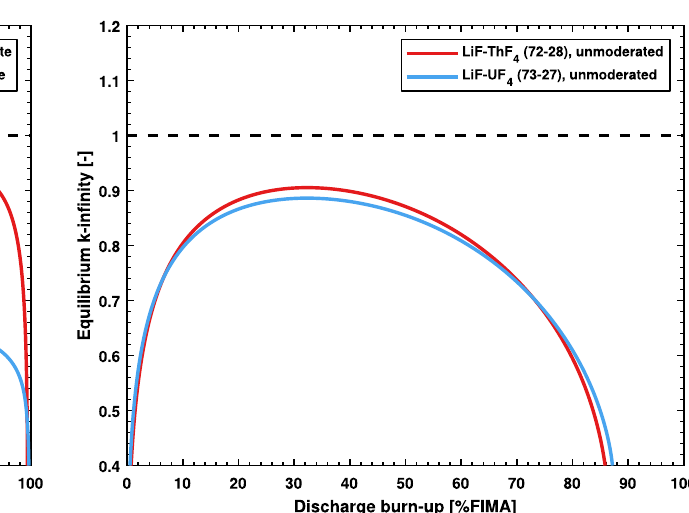
Fig. 6. Achievable equilibrium k ∞ as function of the discharge burn-up for fluoride salts in a fast